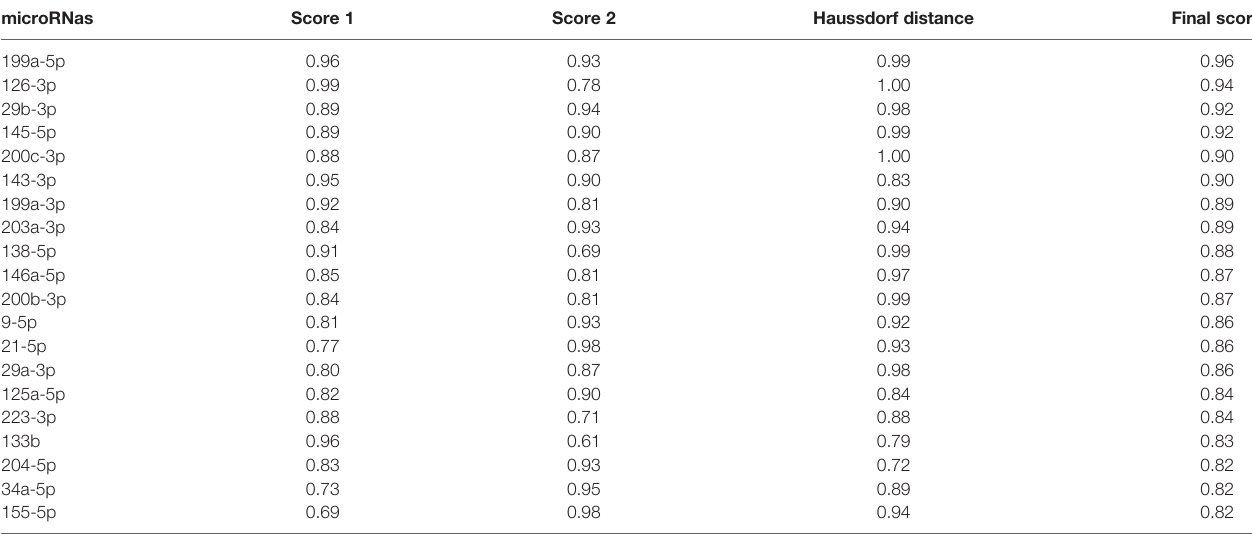
TABLE 1 | List of microRNAs included in the study after simple topological analysis (Anaxomics ® ) ordered by rank. microRNas